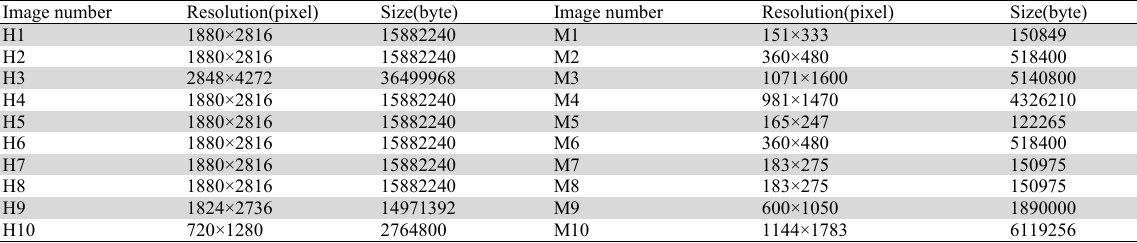
Selected images and basic